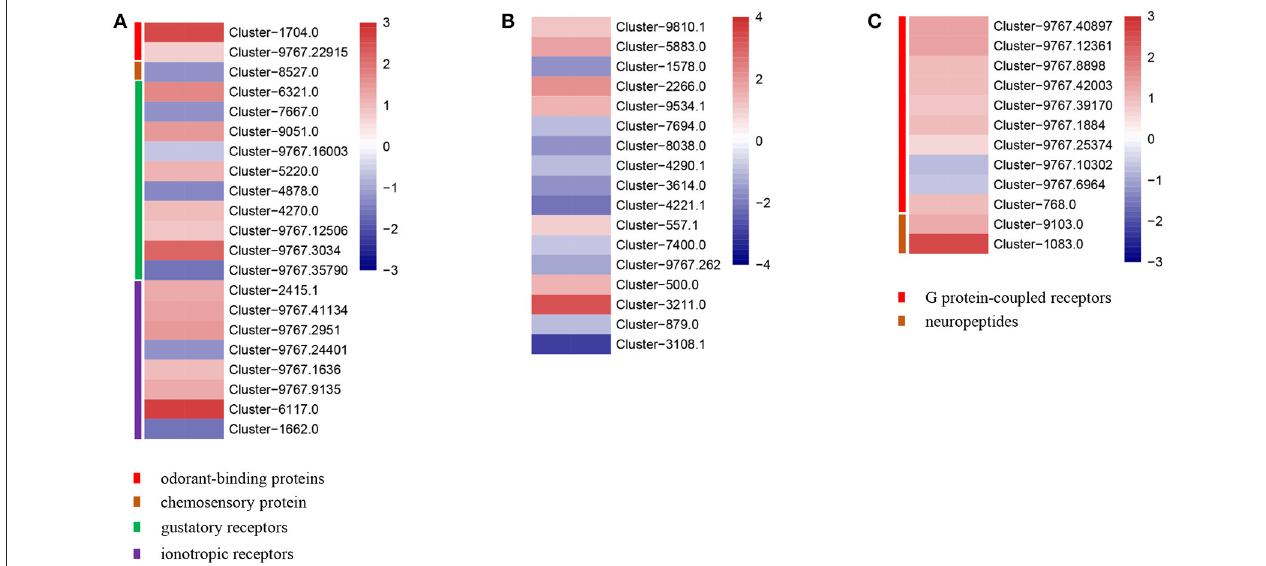
FIGURE 4 | Heatmaps of expressions for genes with neuron and odorant related functions. (A) Genes identified as odorant-binding proteins, chemosesory proteins, gustatory receptors, and ionotropic receptors. (B) Genes identified as odorant receptors. (C) Genes involved in neuron functions.